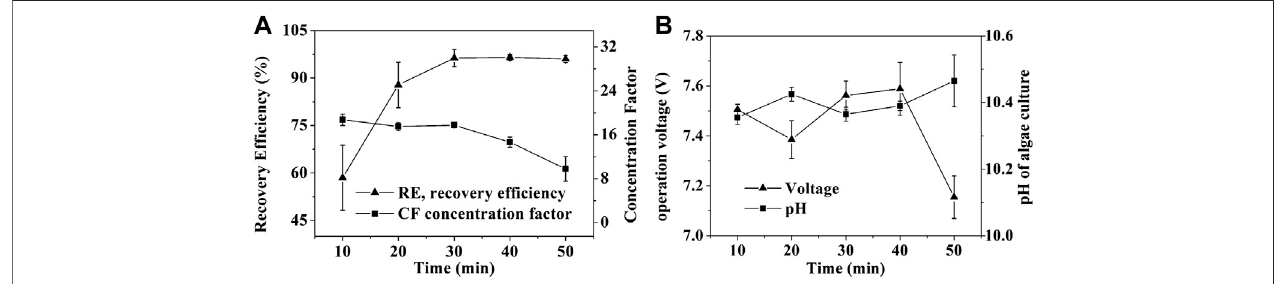
FIGURE3| Effectofbiomassdensity onSBEFwhen harvesting N.oculata at 450 mA: (A) recoveryef fi ciency; (B) concentration factor; (C) pHofalgaeculture; (D) operation voltage; 1X stands for ~1.4 g/L of the group in one-fold biomass density. Data were average ±standard deviation of three independent determinations.